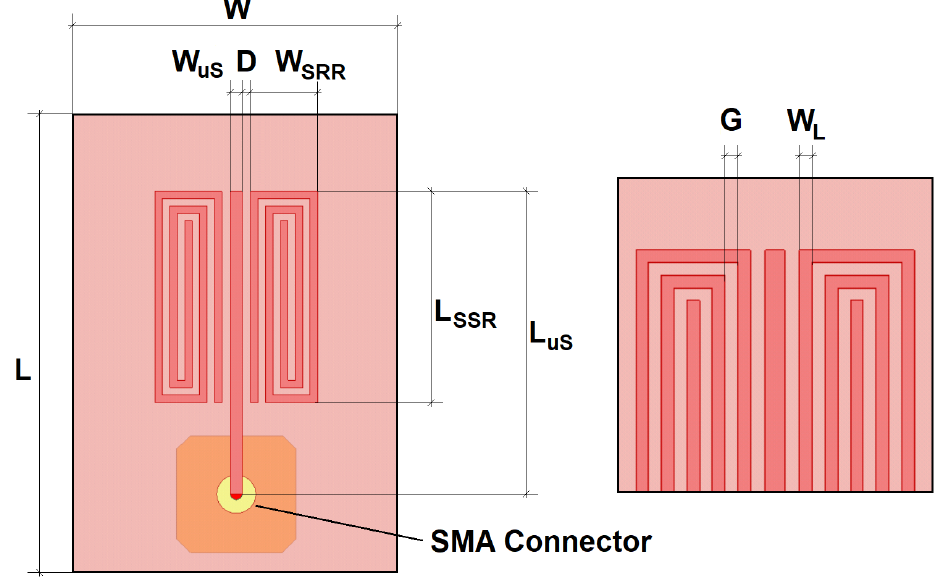
Figure 3. Sketch of the B-type SRR-based sensor. The inset shows a detail of the microstrip open termination.